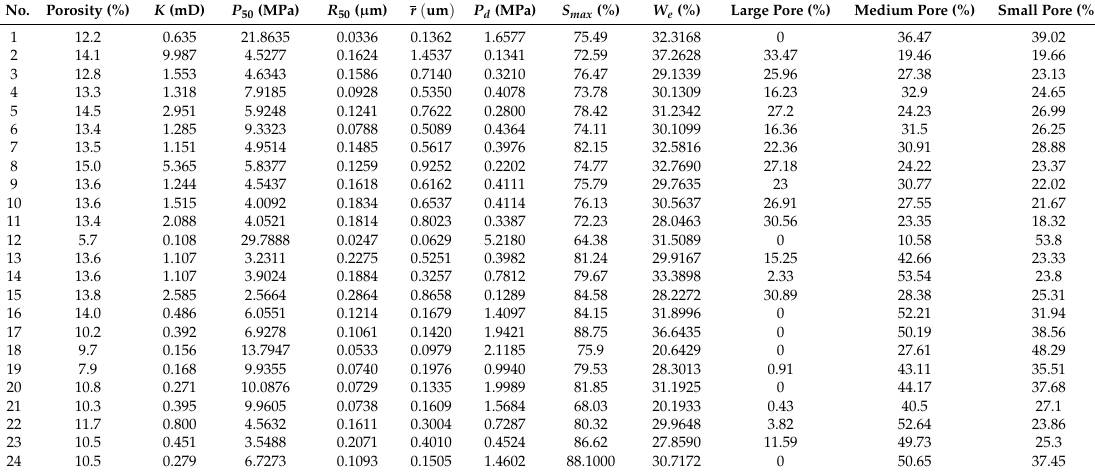
Table 1. The porosity, permeability and mercury injection capillary pressure (MICP) parameters of samples.